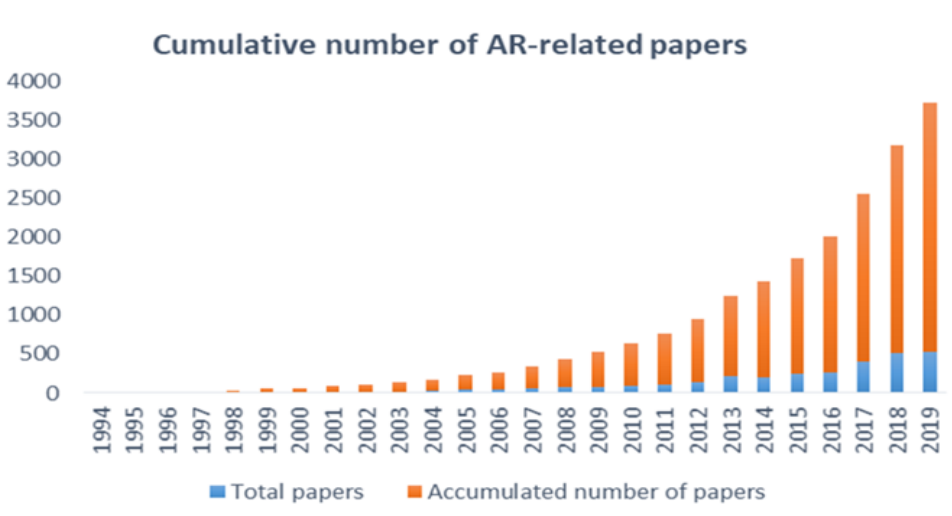
Figure 3. Cumulative number of AR-related papers.